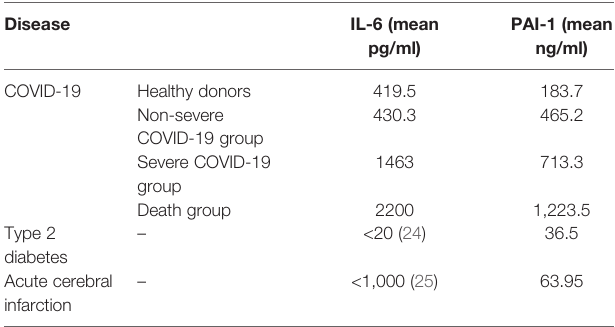
TABLE 2 | The expression of IL-6 and PAI-1 in COVID-19 and underlying diseases. Disease IL-6 (mean